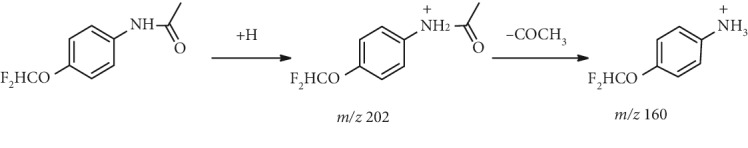
Schematic diagram of DMBZ and potential genotoxic impurities.